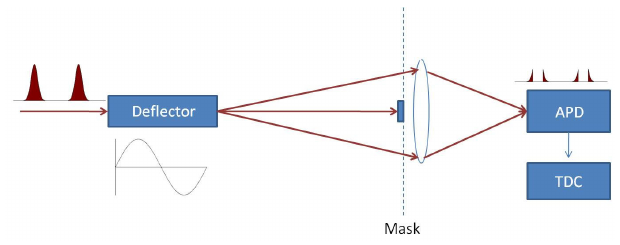
FIG. 11. Schematic of the optical switching scheme.